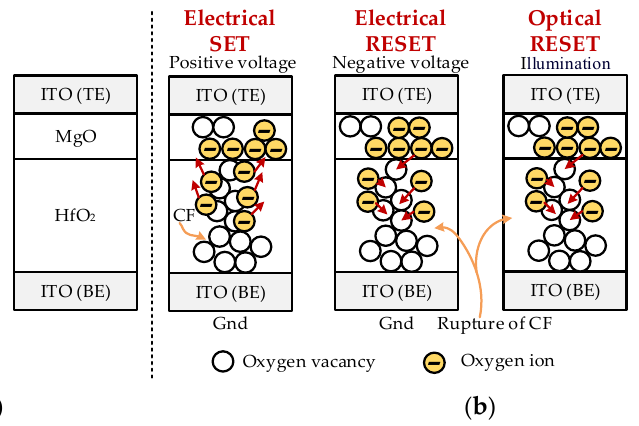
Figure 1. The schematic diagram of the optoelectronic memristor showing ( a ) device structure; and ( b ) working principle.